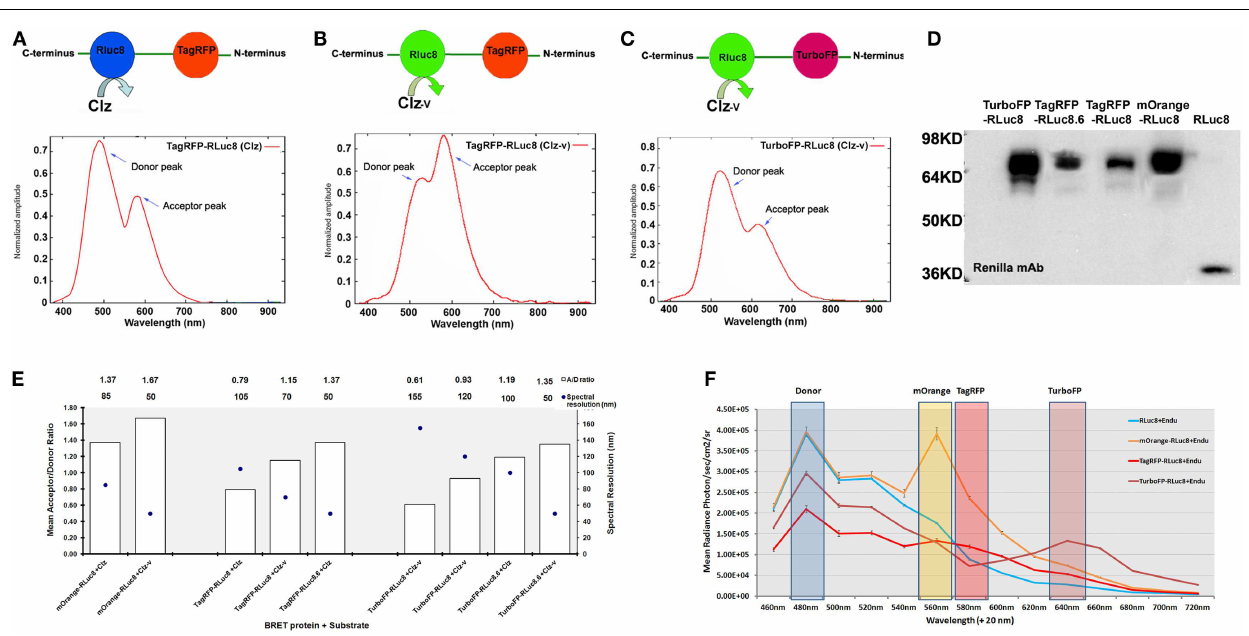
cells expressing the proteins. Spectral resolutions (difference between the donor and acceptor emission peaks) are also plotted on the Z -axis (as dark circles). One can observe an inverse relationship between the BRET ratio measured and the spectral resolution of the BRET partners which is more or less linear in fashion. In some cases, the BRET ratio was seen to be >1 which is theoretically not possible.This is because the values mentioned here are the raw measured values without accounting for the C f value. Once the C f value is added into the equation, the BRET ratios drop below 1. Note that either Clz- h or Clz- v substrate analogs can be used against the same fusion protein to fine tune the spectral resolution. (F) Spectral profile measured from live mammalian cells over-expressing RLuc8, mOrange-RLuc8,TagRFP-RLuc8, andTurboFP-RLuc8 fusion proteins. Cells over-expressing these proteins were exposed to live cell substrate EnduRen TM (Endu) and emission profiles were imaged using IVIS spectrum imaging system loaded with 20nm band-pass filters between 460 and 720nm.This arrangement provides a multiplexing opportunity, where the same donor protein can be combined with multiple acceptors, whose E mmax can be resolved by band-pass filter sets as indicated on the